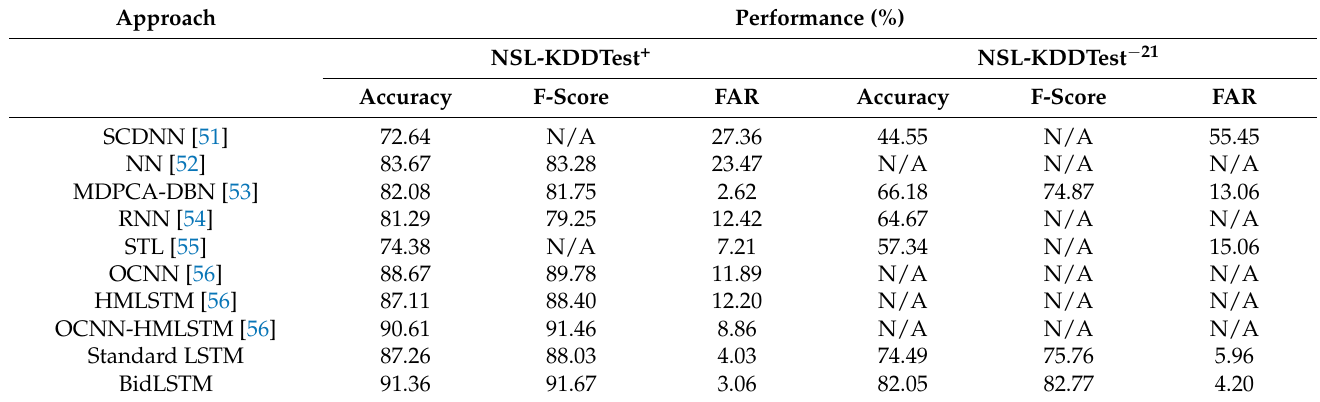
Table 11. Performance comparison against existing methods in the literature using all 41 features (N/A denotes not